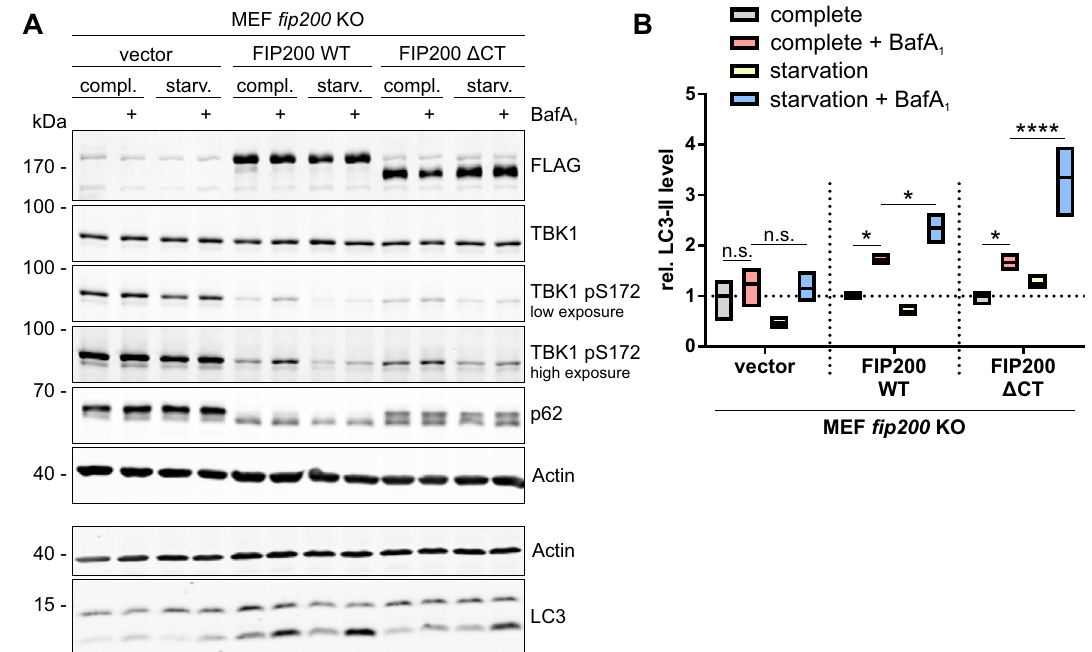
Figure 5. The C terminus of FIP200 is dispensable for starvation-induced autophagy. ( A ) fip200 KO, FIP200 WT, and FIP200 ΔCT MEFs were cultured in complete or starvation (EBSS) medium in either the absence or presence of 10 nM BafA 1 for 2 h. Cleared cellular lysates were immunoblotted for the indicated proteins. The FIP200 cDNAs used for reconstitution of fip200 KO MEFs encoded an N-terminal FLAG peptide. The full- length blots are presented in Figure S8. ( B ) The densities of the bands on immunoblots from three independent experiments were quantified and normalized to those of Actin. The normalized densities of all samples of each cell line were then normalized to that of the respective untreated control sample. Only the relative levels of LC3-II are shown. The boxes represent the highest and the lowest value, while the centerline shows the mean. Two-way ANOVA with uncorrected Fisher’s LSD test was used to determine differences between treatments. n.s. = not significant; *p < 0.05; ****p <